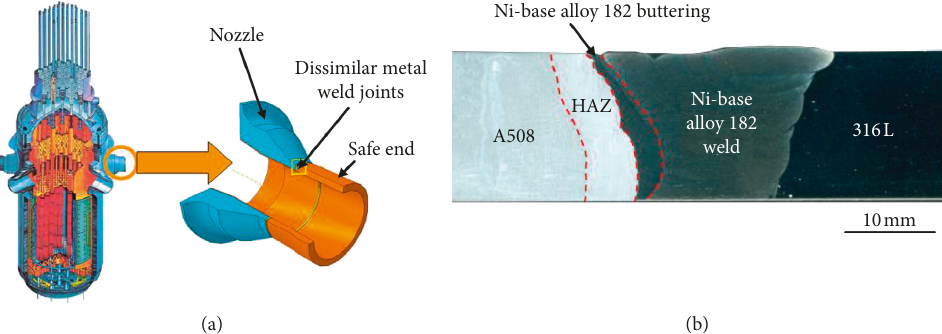
Figure 1: Dissimilar weld joints connecting the RPV nozzle and the hot-leg pipe in NPPs: (a) weld joint position and (b) sectional view of material composition of the weld joint.